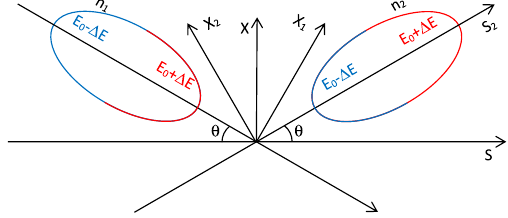
FIG. 6. Monochromatization for crossing angle collision with correlation between particle ’ s energy and longitudinal position.